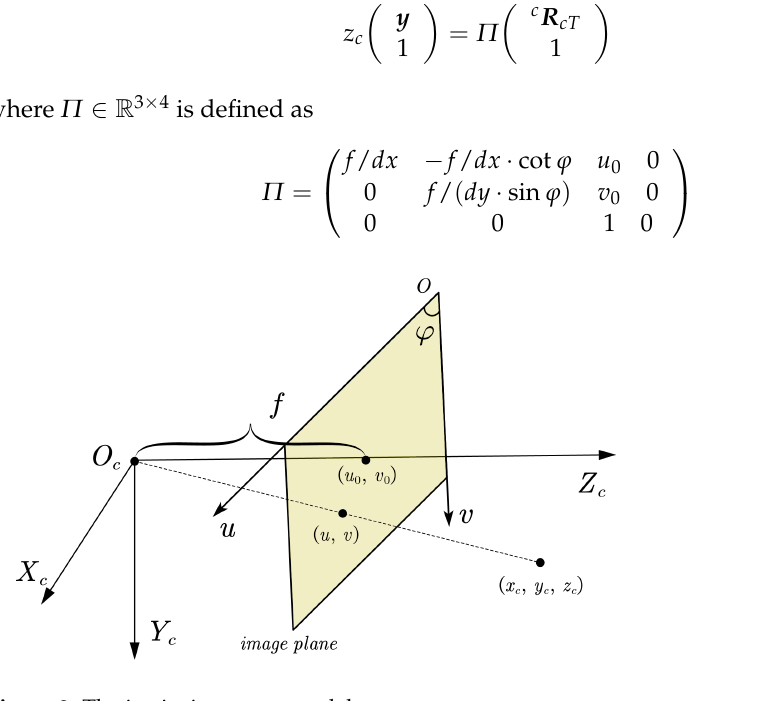
Figure 2. The intrinsic camera